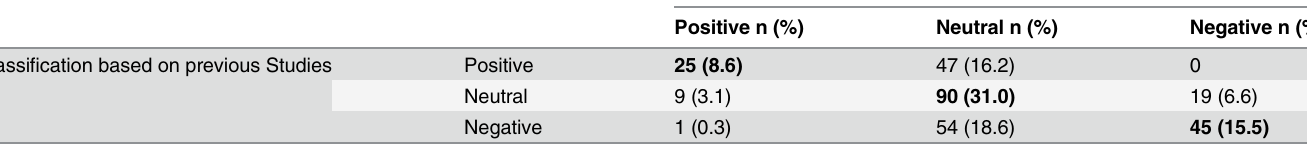
Table 2. Concordance rate by valence of words.